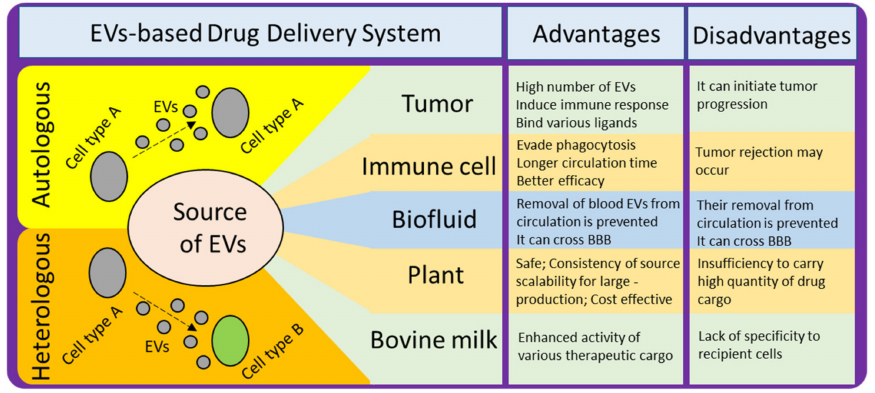
Figure 4. Different sources of EVs for developing EV-based DDS, their advantages, and